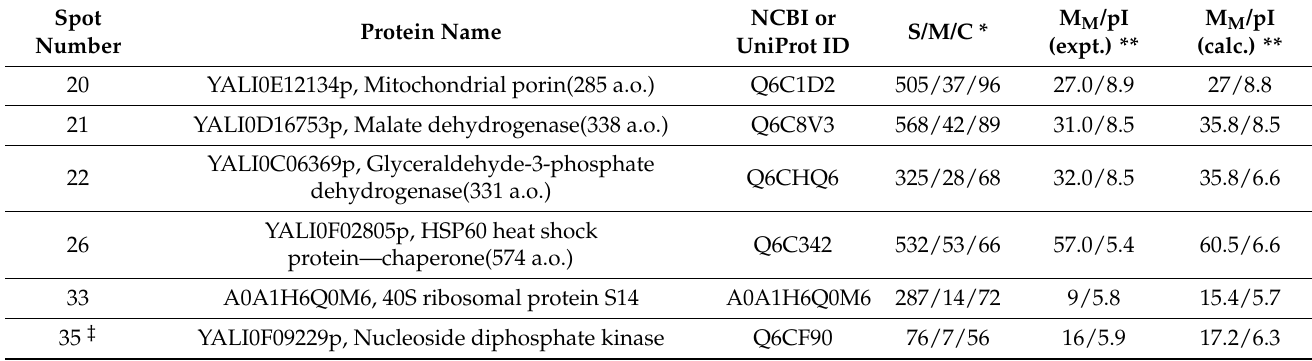
Figure 2. Comparative proteomics analysis of the effect of alkaline stress on protein expression. Summary of various expression levels of Y. lipolytica total protein extracted under normal ( A ) and alkaline ( B ) stress conditions. Symbols: overexpressed proteins under normal (blue arrow) and alkaline stress (red arrow) condition. Table 3. The list of up-regulated proteins in response to alkaline stress in the Y. lipolytica yeast using mass spectrometry (MALDI-TOF MS and MS/MS) under alkaline